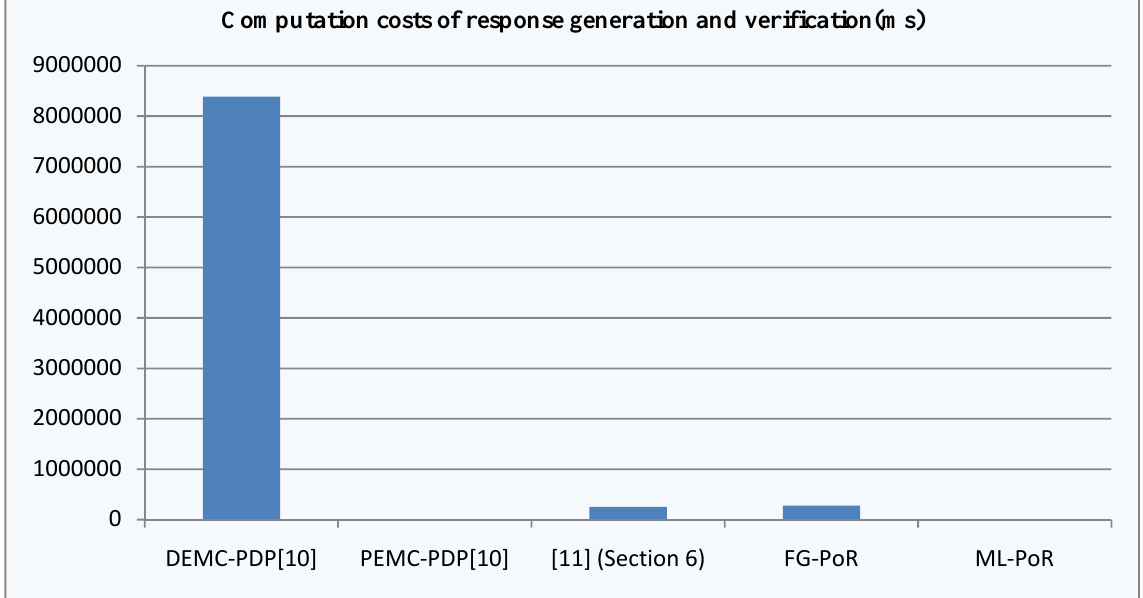
Figure 5. Computation costs of response generation and verification of the five